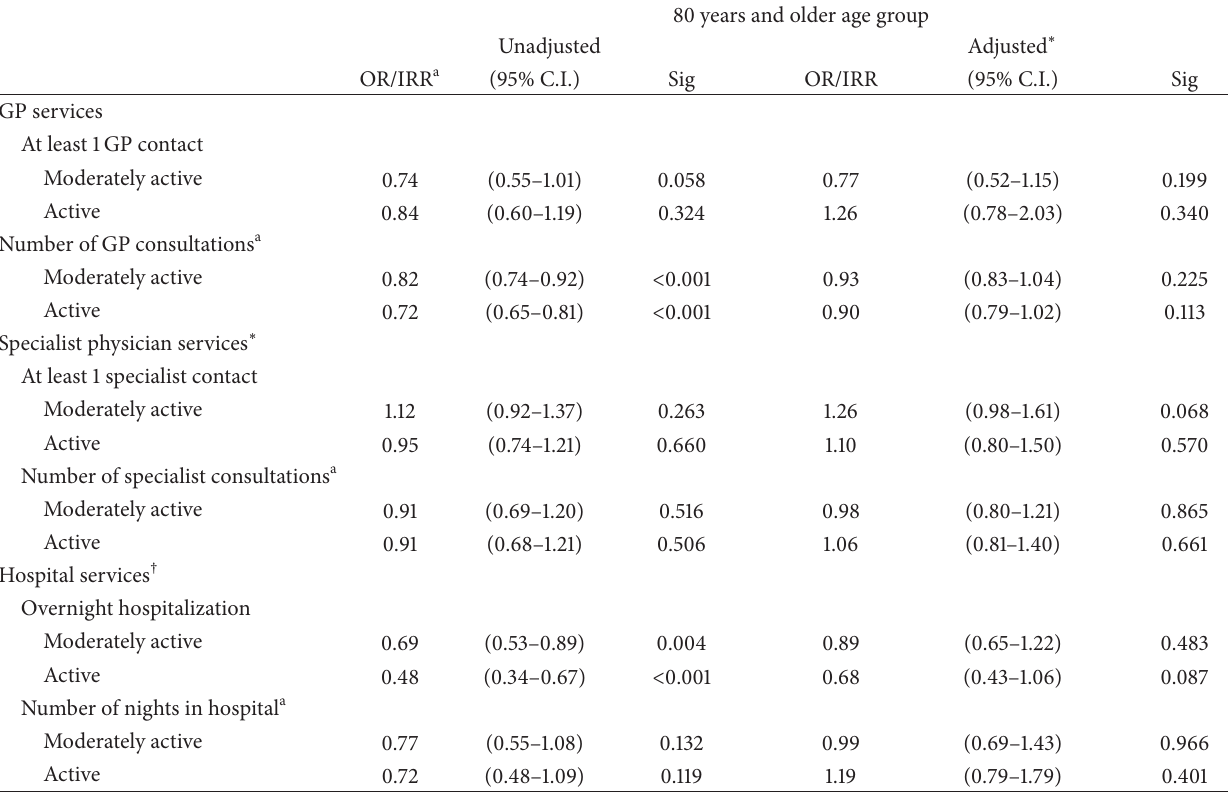
Table 6: The association between LTPA and health services utilization in the 80 years and older age group ( 𝑁 =